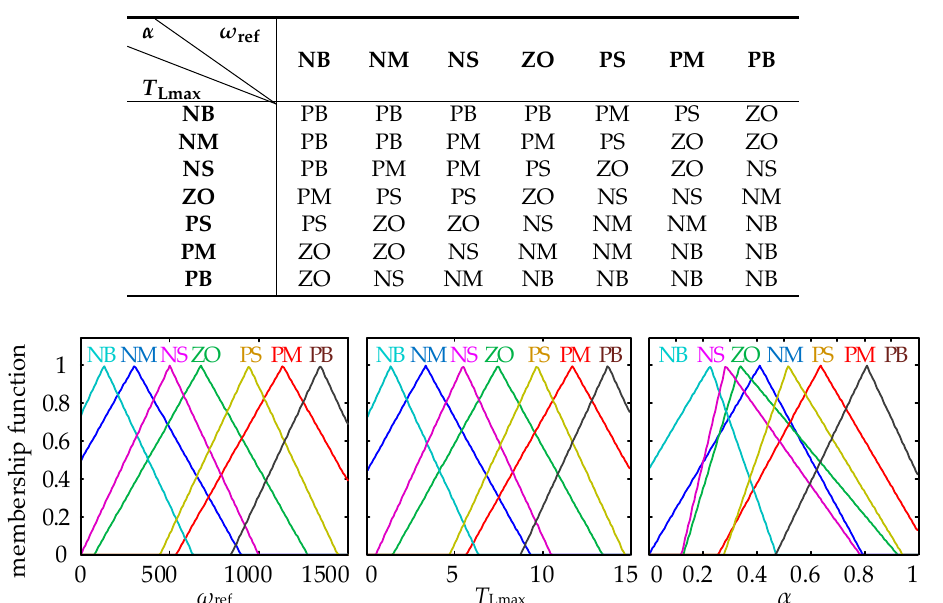
Table 1. Fuzzy control rules. NB: Negative Big; NM: Negative Medium; NS: Negative Small; O: Zero; PS: Positive Small; PM: Positive Medium; PB: Positive Big.